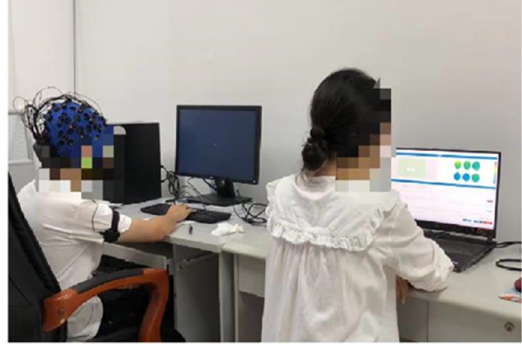
Figure 6. Experiment in progress.